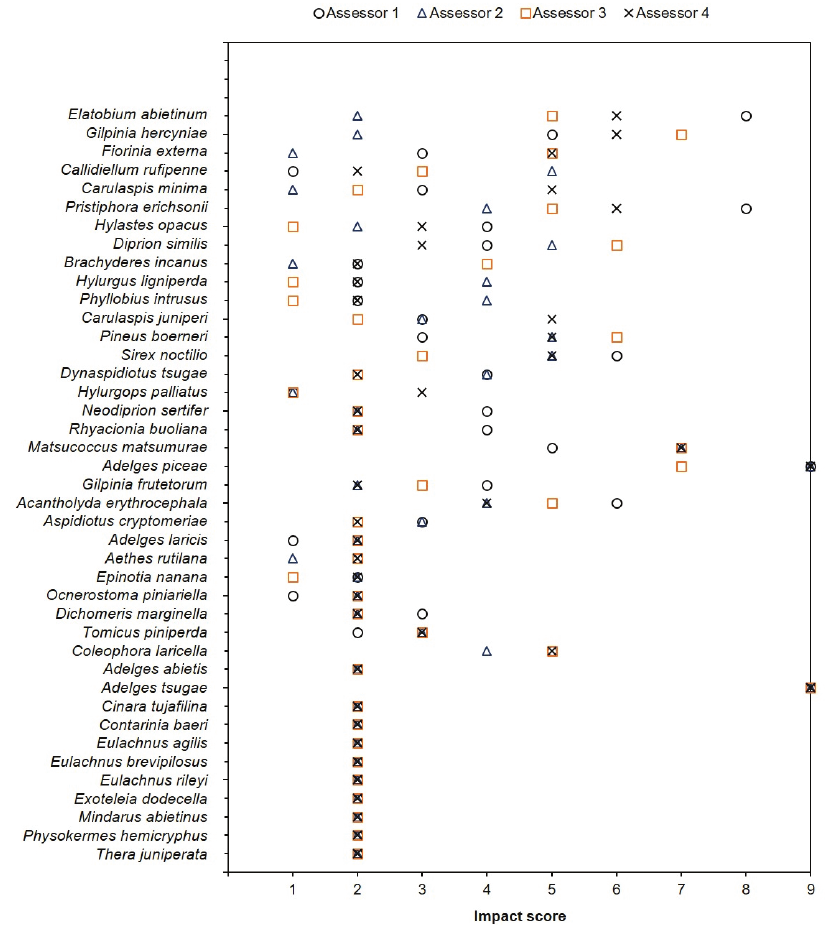
Figure 3. Insect impact scores assigned by each of the four assessors for each insect. Insects with the most dis- agreement are at the top of the figure, whereas insects with the most consensus are at the bottom of the